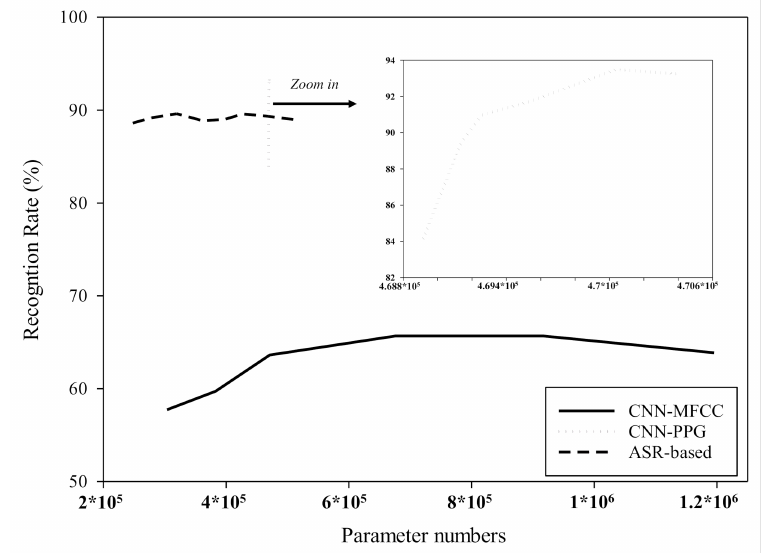
Figure 3. Comparison of difference model size of the three used models. The x-axis denotes the parameter numbers, and the y-axis denotes the recognition rate of speech command from dysarthric